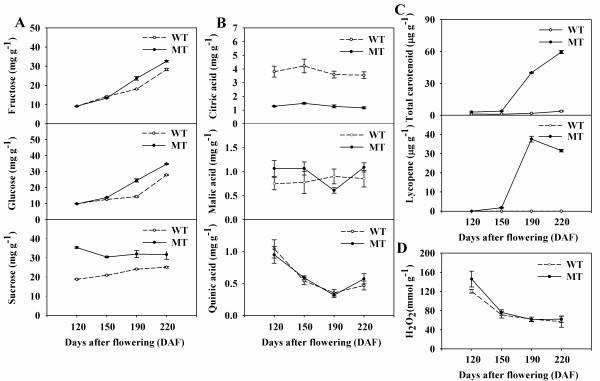
Dynamics of soluble sugar, organic acid, total carotenoid, lycopene and H2O2 accumulation during fruit development and ripening . The concentrations of soluble sugars (A) and organic acids (B) were determined by GC. The total carotenoid and lycopene (C) contents have been published previously [20]. The H2O2 content (D) was determined by spectrophotometer at 450 nm. 'Anliu' sweet orange (WT, broken line) and its red flesh mutant (MT, solid line) fruits at each of four selected developmental stages were used in the analysis. Bars represent the standard error (n = 3). DAF, days after flowering.